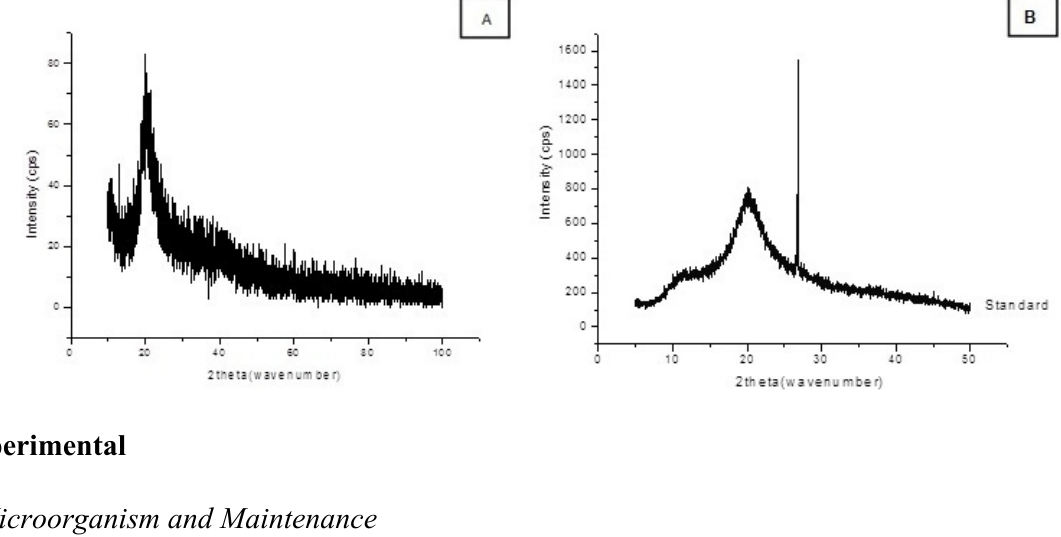
Figure 4. X-ray diffractograms of chitosan. ( A ) Microbiological chitosan of C. elegans in the best condition of the full factorial design. ( B ) X-ray diffractograms of commercial